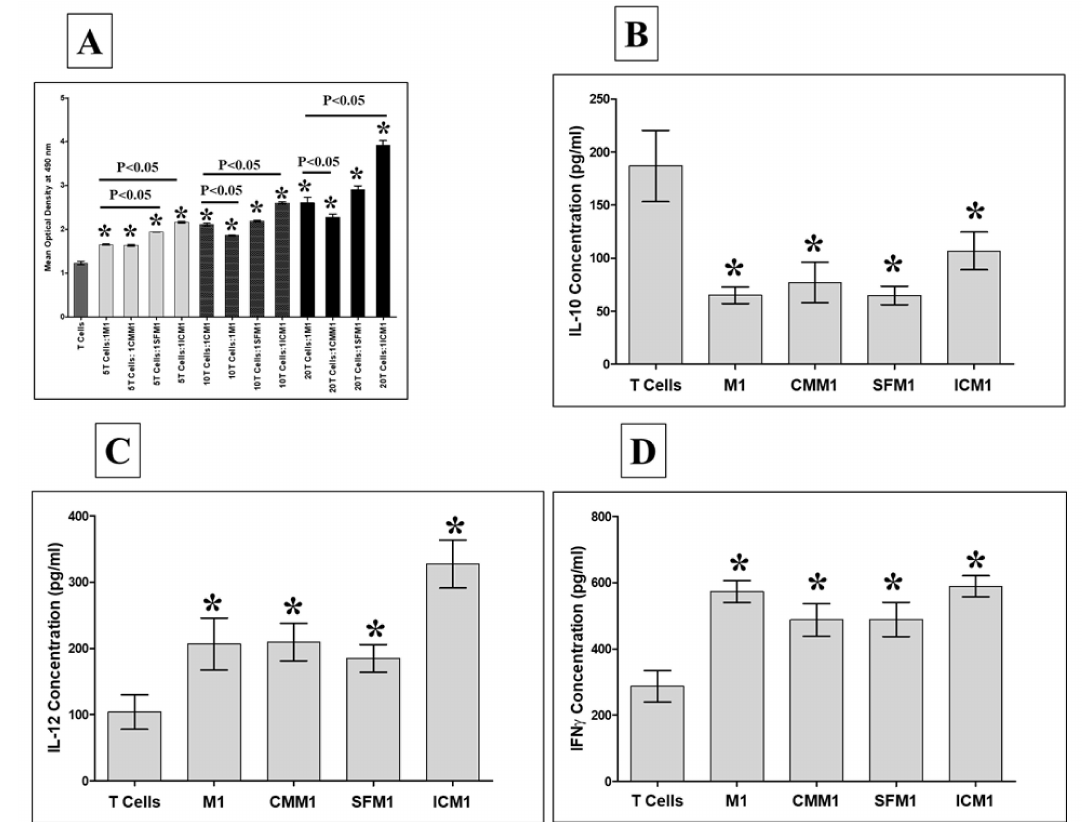
Figure 9. T cell proliferation by M1-like macrophages (M1) generated in the presence of DBMSCs. After culturing M1 alone or with CMDBMSC (CMM1), SFDBMSC (SFM1), and ICDBMSC (ICM1), M1 were harvested and added to allogeneic CD4 + T cells at 5:1, 10:1, and 20:1 T cells:M1 (M1, CMM1, SFM1, and ICM1) ratios. M1 pre-treated with DBMSCs (CMM1, SFM1, and ICM1) or without (M1) significantly increased T cell proliferation at all indicated ratios. Similarly, ICM1 significantly increased T cell proliferation at all indicated ratios compared to that with M1, while SFM1 significantly increased T cell proliferation at the 5:1 T cells: SFM1 ratio compared to that with M1. By contrast, CMM1 significantly decreased T cell proliferation at the 10:1 and 20: 1 T cells: CMM1 ratios compared to that with M1 ( A ). In addition, the secretion of IL-10 by T cells stimulated with M1, CMM1, SFM1, and ICM1 was significantly reduced ( B ), while the secretion of IL-12 and IFN- γ was significantly increased, p < 0.05 ( C and D ). Experiments were carried out in triplicate and repeated 10 times using 10 individual preparations of T cells and macrophages harvested from 10 individual experiments of macrophages cultured with DBMSCs (CMDBMSC, SFDBMSC, and ICDBMSC). * p < 0.05, Bars represent standard